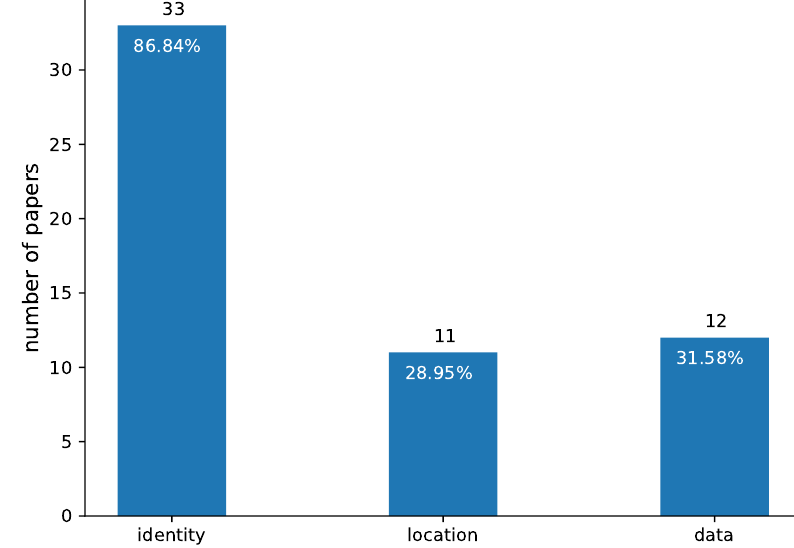
Figure 5. Privacy types (RQ2) presented in the papers included in our review.